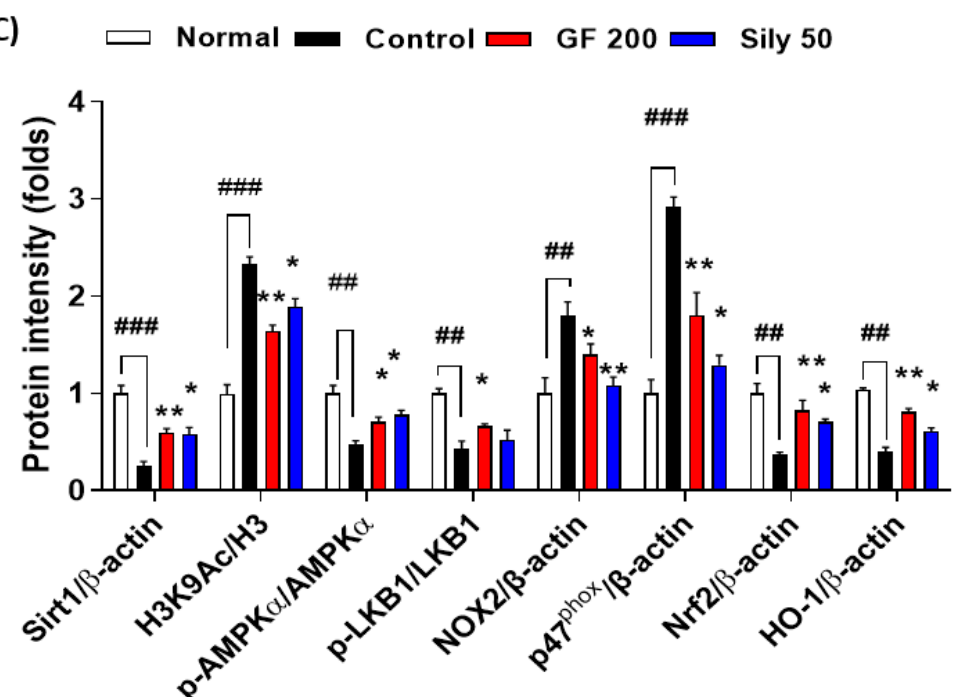
Figure 5. GF ameliorates liver fibrosis via regulations of AMPK/SIRT1 signaling pathways. Western blot analysis of SIRT1 and its deacetylate target proteins such as H3K9Ac, Total H3, p-AMPK α , and AMPK α , p-LKB1, and LKB1 ( A ), and NOX2, p47 phox , Nrf2, and HO-1 ( B ). ( C ) Quantification analysis of Western blot analysis. Data were expressed mean ± SEM ( n = 3 for each group for Western blot analysis). ## p < 0.01 and ### p < 0.001 for Normal vs. Control; * p < 0.05 and ** p < 0.01 for Control vs. GF 200 or Sily 50.